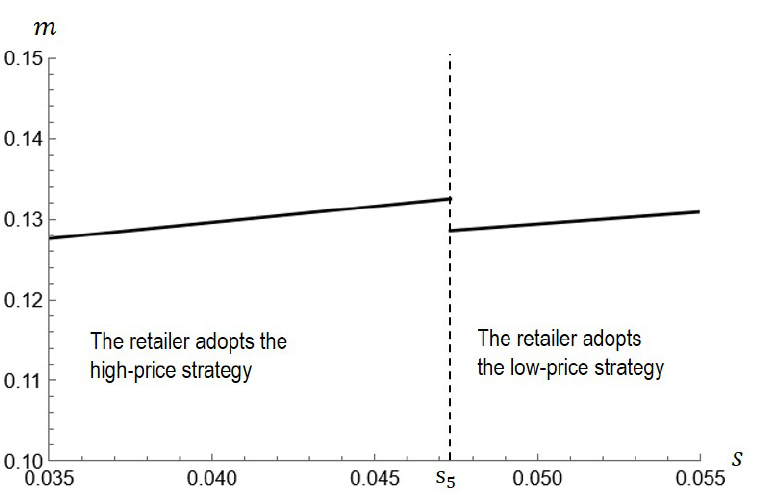
Figure 5. The premium changes in s in scenario RN ( c = 0.4, θ = 0.6, λ l = 0.4, λ h = 0.6, β = 2, h =